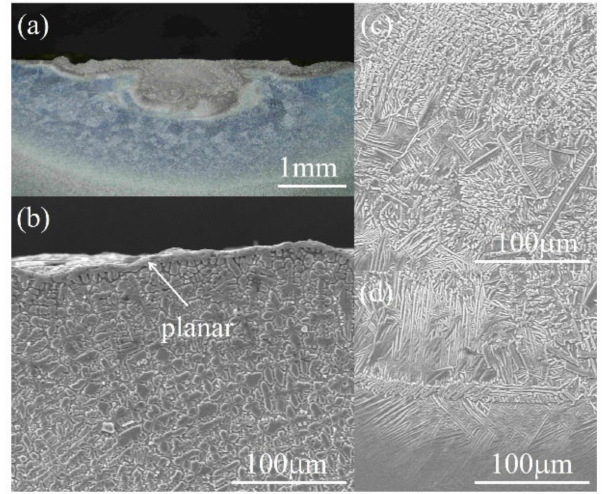
Figure 8. Optical microscope ( a ) and SEM image ( b – d ) of the nitrided layer in the 72% nitrogen and 28% argon atmosphere. ( a ) The cross section of the nitrided layer, ( b ) the microstructure of the nitrided layer, ( c ) the zone between the nitrided layer and the heat-a ff ected area, and ( d ) the heat-a ff ected area and